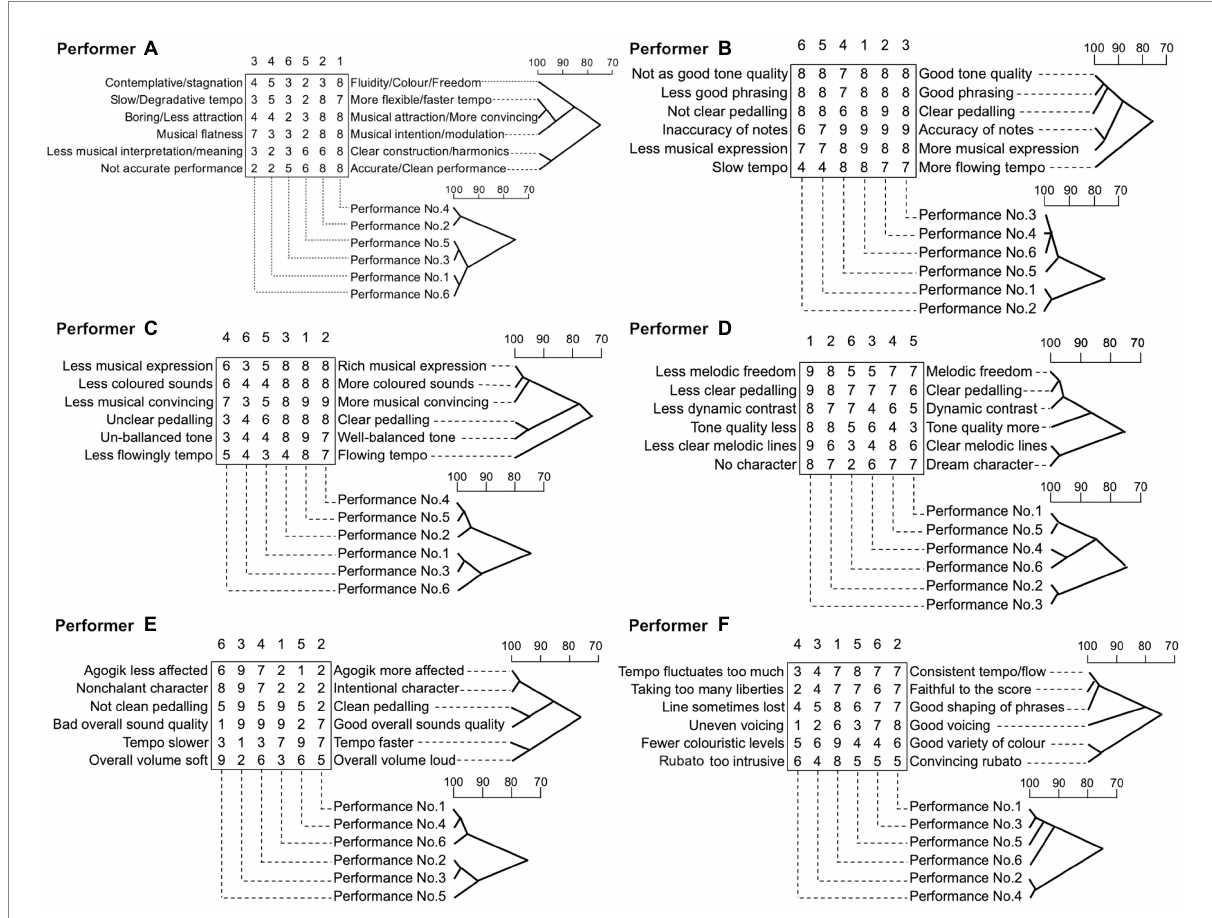
FIGURE 2 Clusters of performers’ self-evaluations of their own